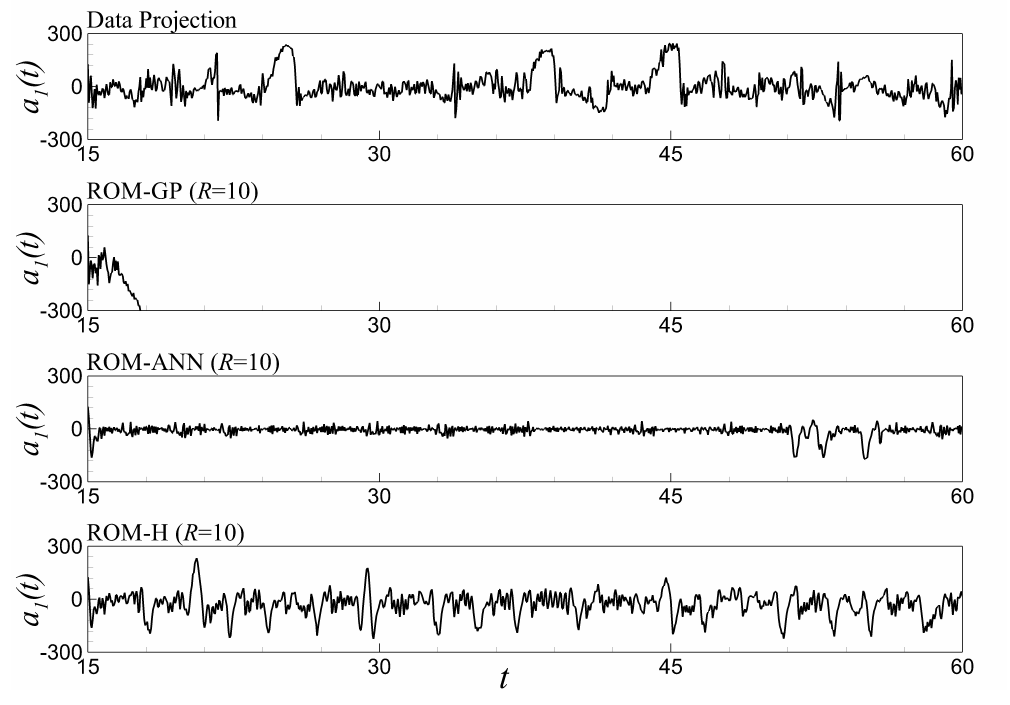
Figure 24. Time series evolution of the first temporal coefficient a 1 ( t ) for the out-of-sample forecast by FOM and different ROM approaches (ROM-GP, ROM-ANN, and ROM-H) using R = 10 POD modes. Predictive performance is shown for Re = 200 while the training has been performed using the data generated at Re = 100.